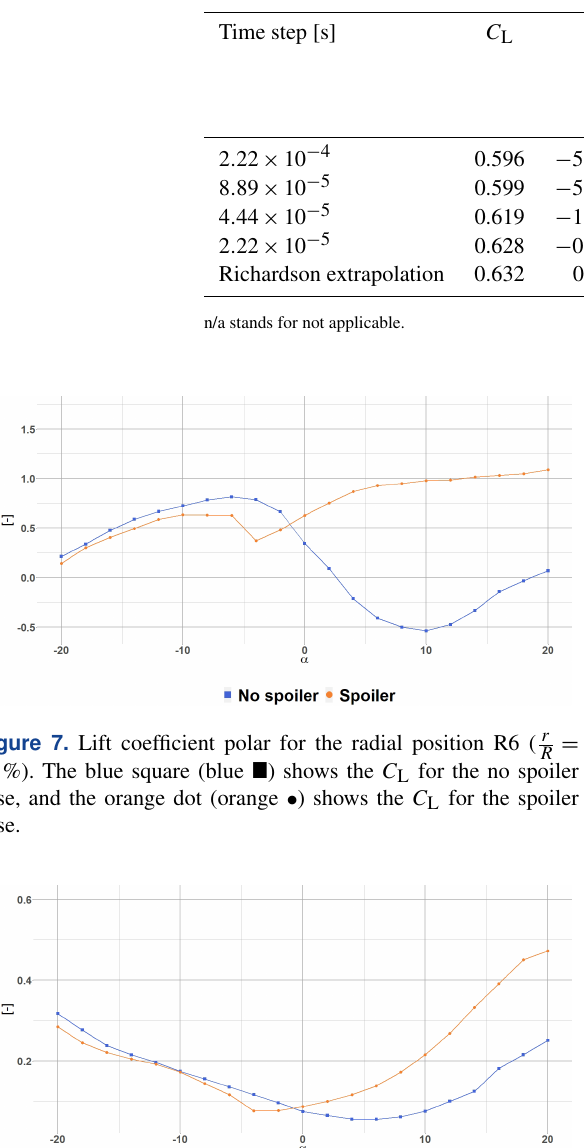
Figure 8. Drag coefficient polar for the radial position R6 ( r 13%). The blue square (blue (cid:4) ) shows the C D for the no spoiler case, and the orange dot (orange • ) shows the C D for the spoiler